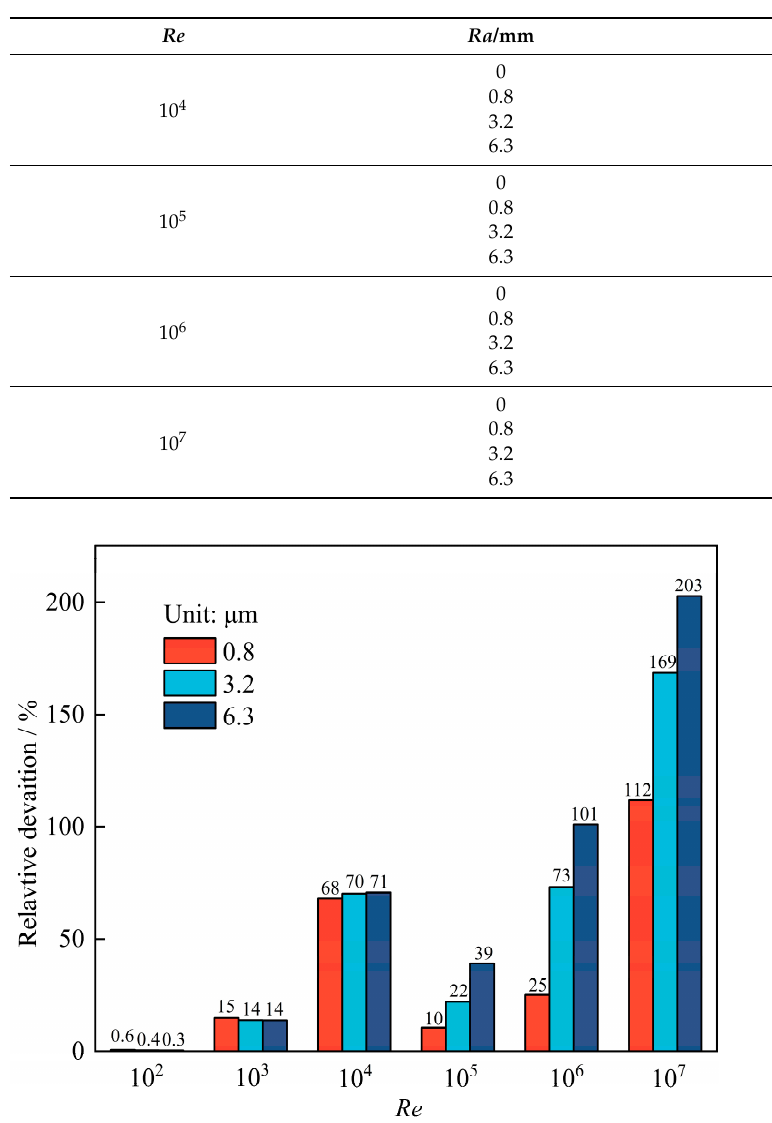
Figure 8. Relative deviation versus Re under Ra of 0.8~6.3 μ m conditions.